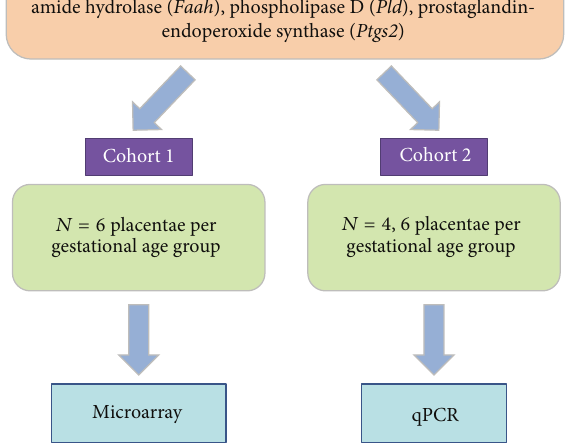
Figure 2: Study design: two independent cohorts of rat placenta samples used for microarray (cohort 1) and qPCR (cohort 2). In cohort 2, we used E14.25, 𝑛 = 6 , E15.25, 𝑛 = 4 , E17.25, 𝑛 = 6 , and E20, 𝑛 = 6 . Note: Ptgs1 was only analyzed by